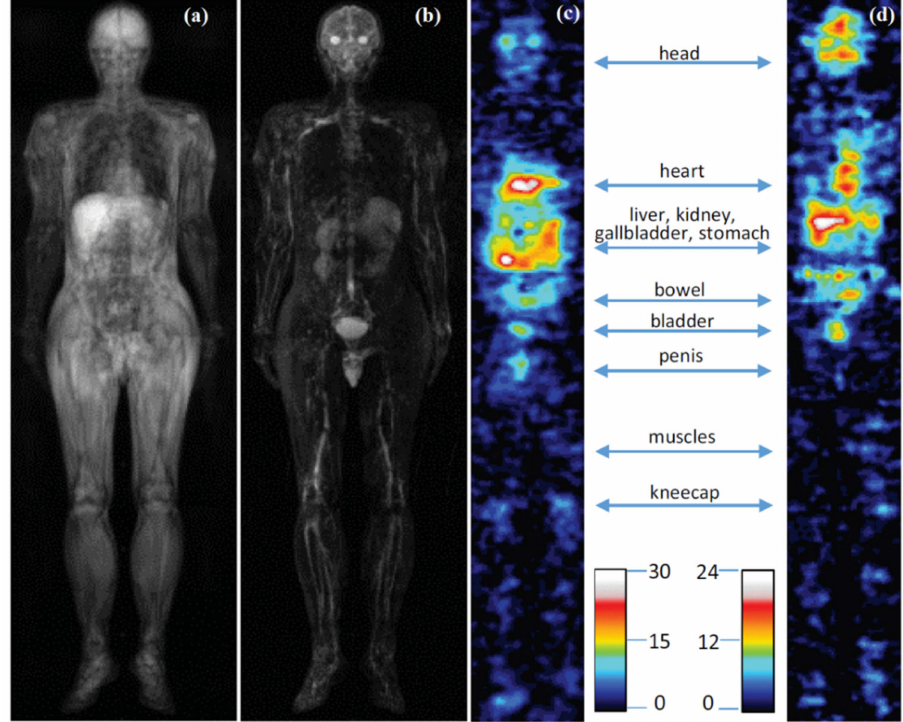
Figure 4. ( a ) Hydrogen WB MRI in supine position; ( b ) sodium WB MRI; ( c ) SNR maps in prone position; ( d ) supine positions. Reprinted by permission from Anisimov et al., App Magn Reson 2019